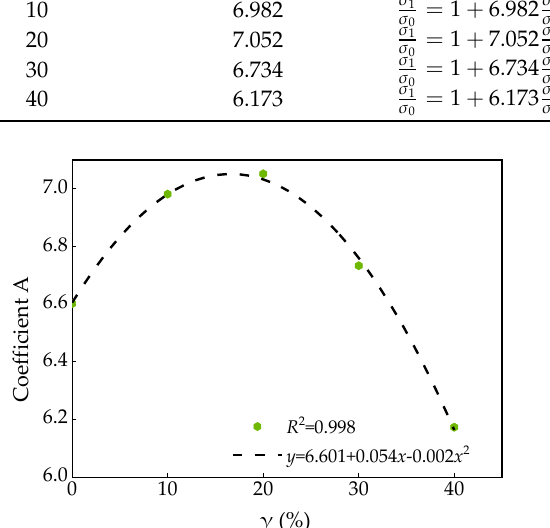
ffi cient A and FA substitution rate γ Figure 14. Relationship between coefficient A and FA substitution rate γ. Figure 14. Relationship between coe